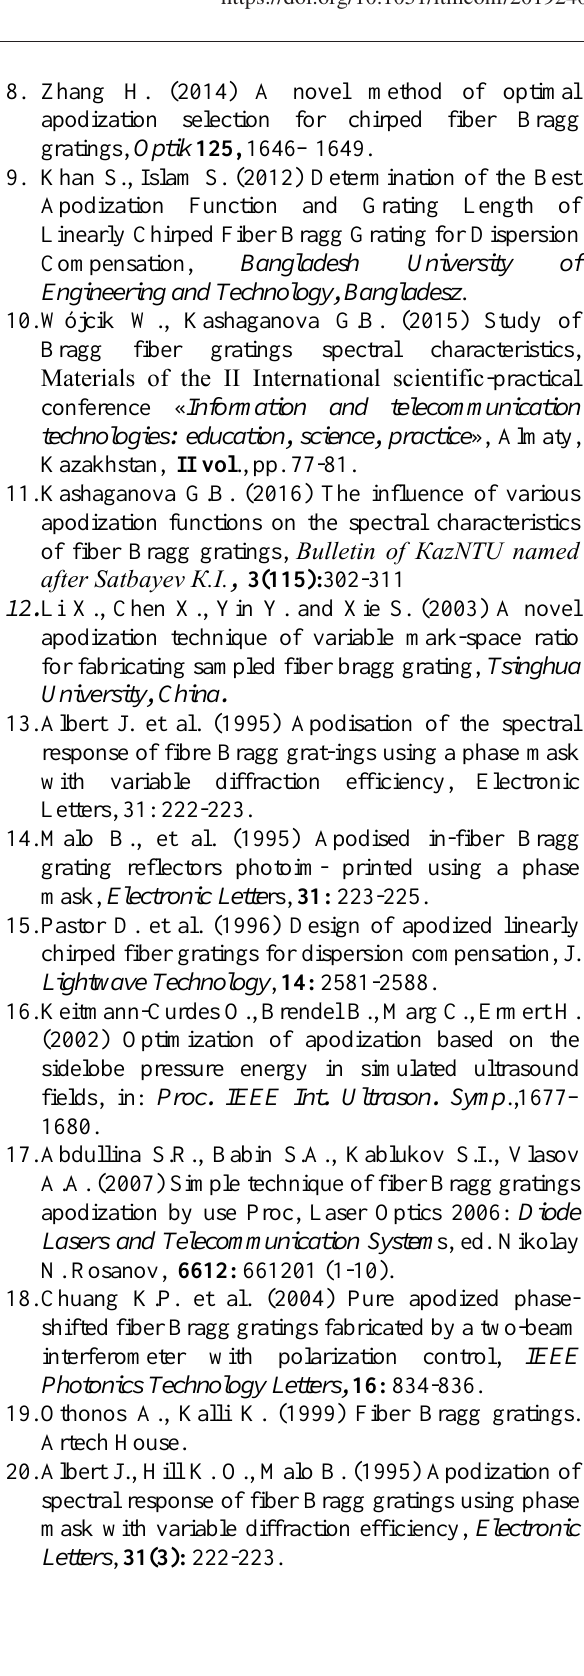
Fig. 29. Chart of the parameter S GW and parameters X and Y of the sinc- apodization